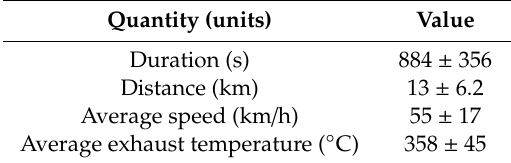
Table 6. Main characteristics of the regeneration events (average ± standard